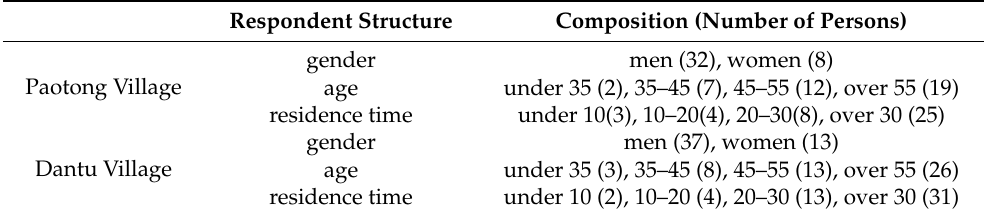
Table 2. The structure of surveyed farmers in two case-study